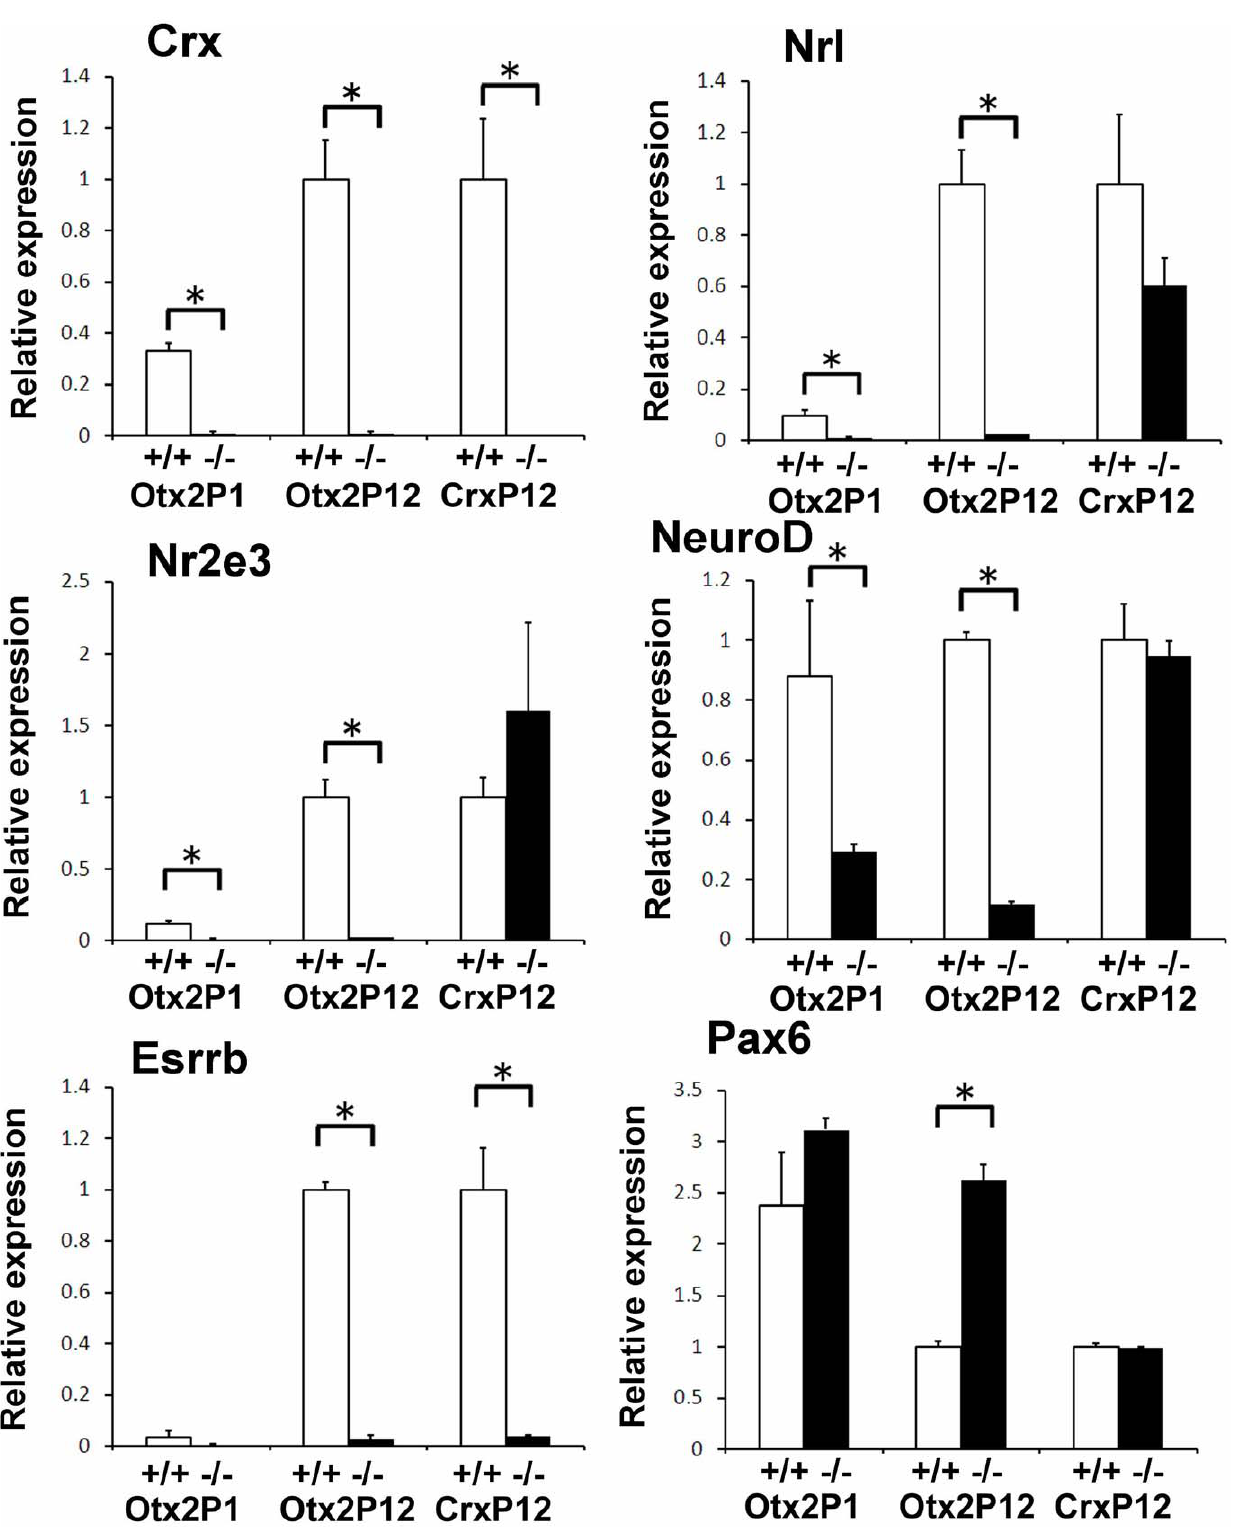
Figure 5. Otx2 regulates expression of transcription factors involved in retinal development. Expression levels of selected transcription factor genes in the control (at P1 and P12), Otx2 CKO (at P1 and P12) and Crx KO (at P12) retinas were analyzed by Q-PCR. Expression levels of selected genes were normalized to the expression levels of a housekeeping gene, Gapdh . The mean of the value of each control at P12 was set as 1.0. Error bars show the SD (n = 3). *, P , 0.03.